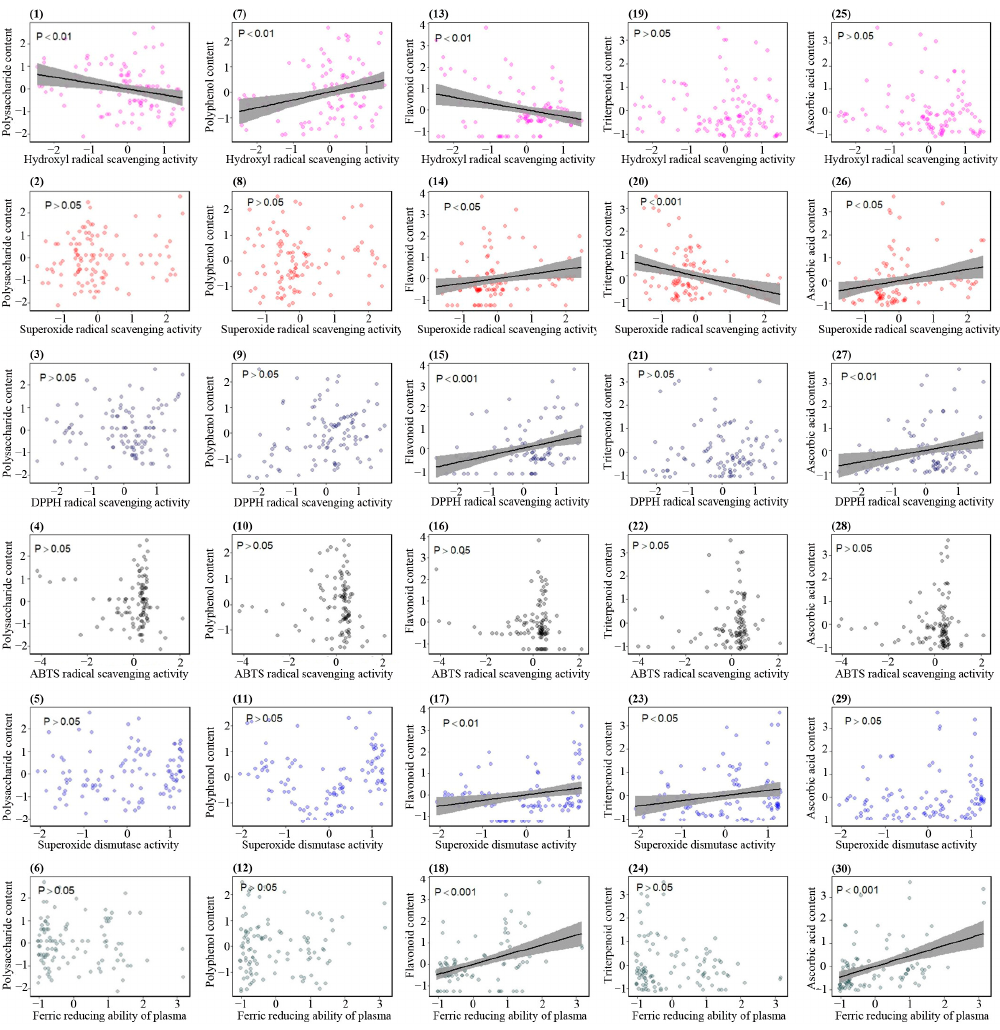
Figure 13. Correlation analysis between bioactive ingredients and antioxidant activities of 15 wild strains from 8 species of Sanghuangporus . ( 1 ) Polysaccharide content and hydroxyl radical scaveng- ing activity. ( 2 ) Polysaccharide content and superoxide radical scavenging activity. ( 3 ) Polysaccha- ride content and DPPH radical scavenging activity. ( 4 ) Polysaccharide content and ABTS radical scavenging activity. ( 5 ) Polysaccharide content and superoxide dismutase activity. ( 6 ) Polysaccha- ride content and ferric reducing ability of plasma. ( 7 ) Polyphenol content and hydroxyl radical scav- enging activity. ( 8 ) Polyphenol content and superoxide radical scavenging activity. ( 9 ) Polyphenol content and DPPH radical scavenging activity. ( 10 ) Polyphenol content and ABTS radical scaveng- ing activity. ( 11 ) Polyphenol content and superoxide dismutase activity. ( 12 ) Polyphenol content and ferric reducing ability of plasma. ( 13 ) Flavonoid content and hydroxyl radical scavenging activ- ity. ( 14 ) Flavonoid content and superoxide radical scavenging activity. ( 15 ) Flavonoid content and DPPH radical scavenging activity. ( 16 ) Flavonoid content and ABTS radical scavenging activity. ( 17 ) Flavonoid content and superoxide dismutase activity. ( 18 ) Flavonoid content and ferric reducing ability of plasma. ( 19 ) Triterpenoid content and hydroxyl radical scavenging activity. ( 20 ) Triterpe- noid content and superoxide radical scavenging activity. ( 21 ) Triterpenoid content and DPPH